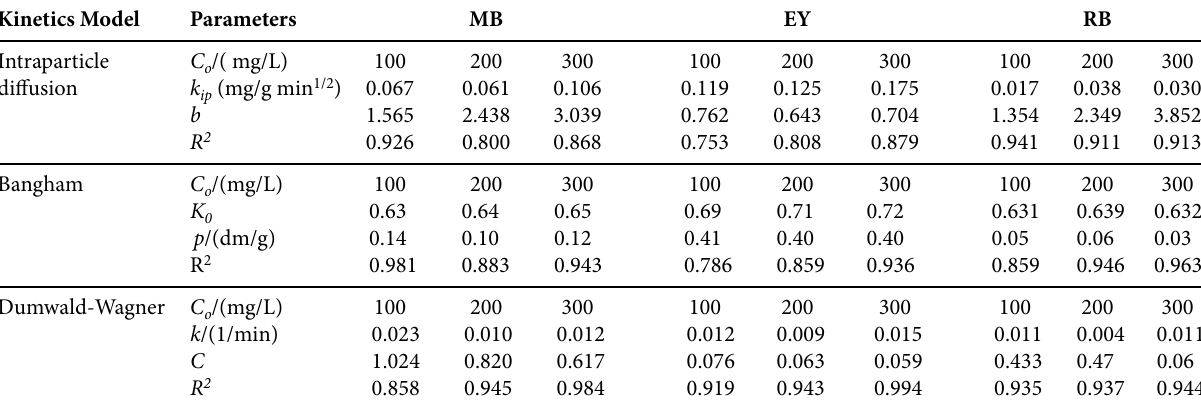
Table 3 . Intraparticle diffusion, Bangham and Dumwald-Wagner rate coefficients for dyes removal on CNAC surface at different initial concentra- tions Kinetics Model